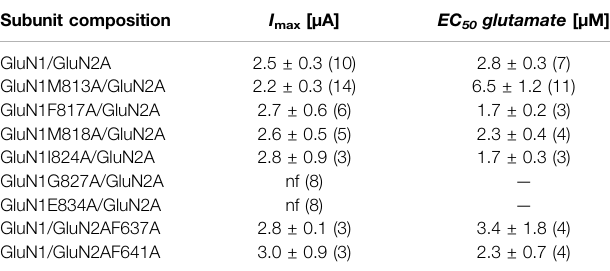
TABLE 1 | I max and EC 50 values of recombinant wild type and mutant GluN1/ GluN2A NMDARs. Subunit composition